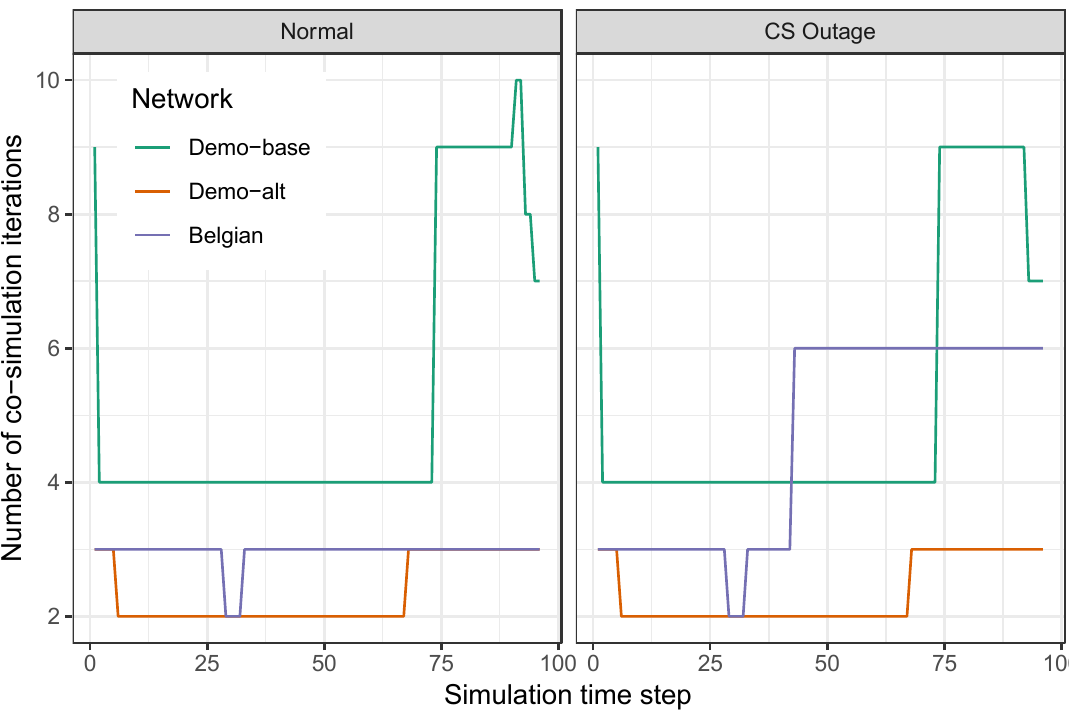
Figure 11. Number of iterations by timestep for the co-simulation approach; results are shown for each combination of network and scenario tested.